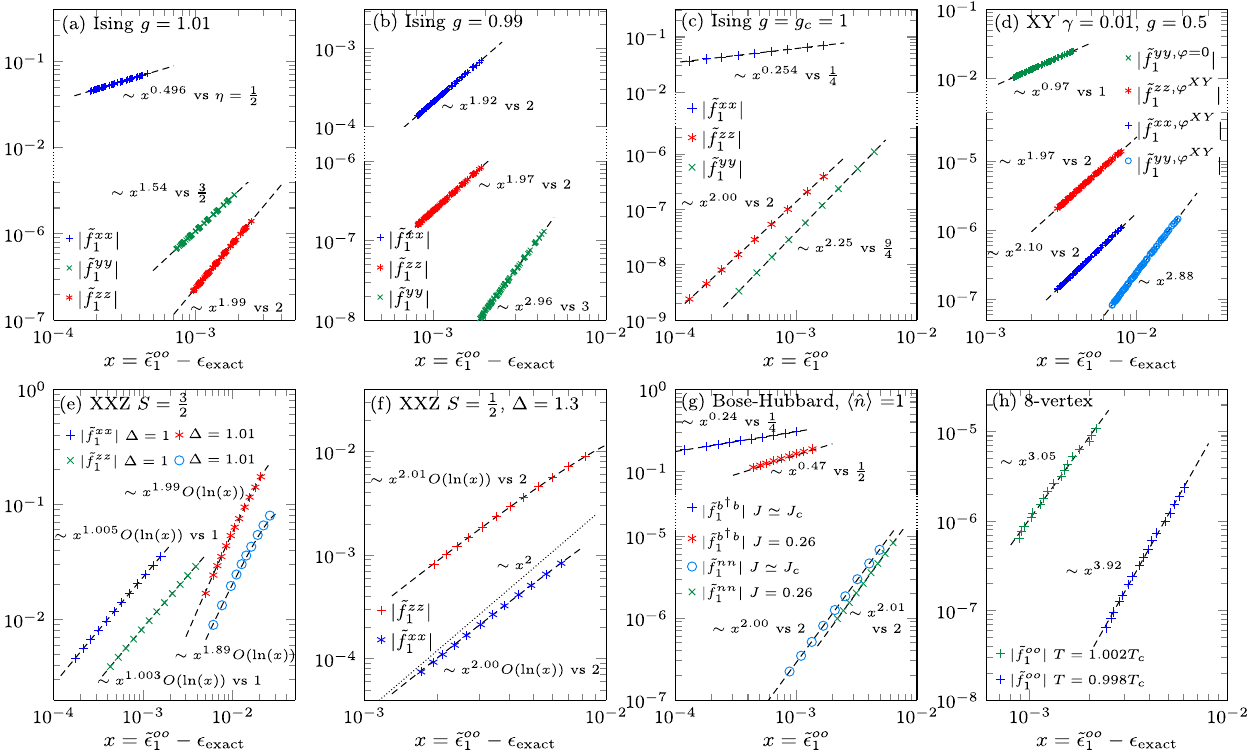
FIG. 10. Nonzero form factors corresponding to dominant TM eigenvalues for all the models discussed in this article. We observe that they decay (as we increase the bond dimension) as a power law with the error of the inverse correlation length, ˜ ϵ oo 1 , extracted directly from the transfer matrix. We observe that the exponent of the power law coincides with the corresponding exponent η of the correlation function asymptotics in Eq. (2). In each plot we show the fitted value of the exponent, as well as the value of η when the analytical result is available. See text for details. In each panel, the order of the legend corresponds to the respective position of different lines. Recall that f oo R Þ ] corresponding to ϵ is the form factor [for some C . ˜ ϵ oo are the eigenvalues for which the form factor is nonzero. Those n m oo ð n ˜ f oo nonzero form factors are marked as n